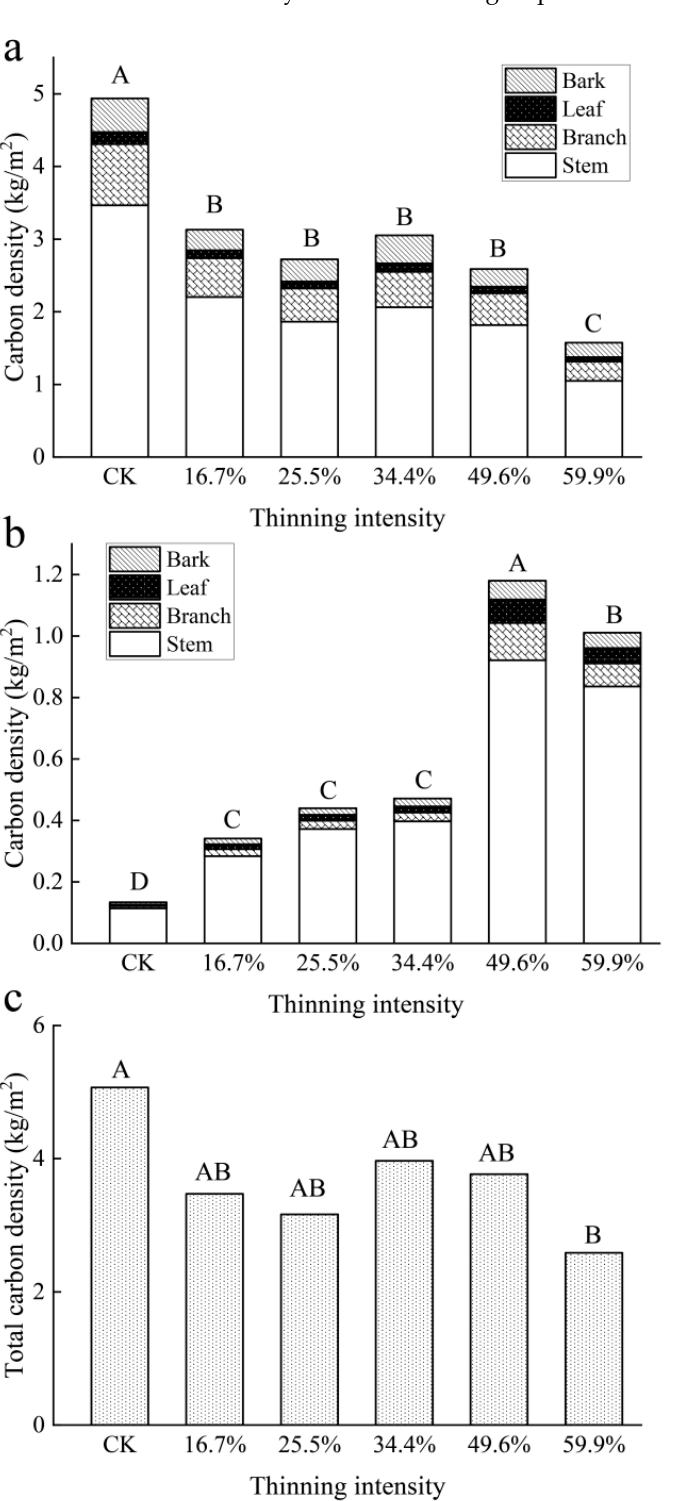
Figure 9. Aboveground carbon density of tree layers. Note: ( a ) is larch carbon density, ( b ) is birch carbon density and ( c ) stand total carbon density. The different capital letters in the same graph denote a statistically significant difference at p < 0.05 of the carbon density between thinning inten- sity groups.